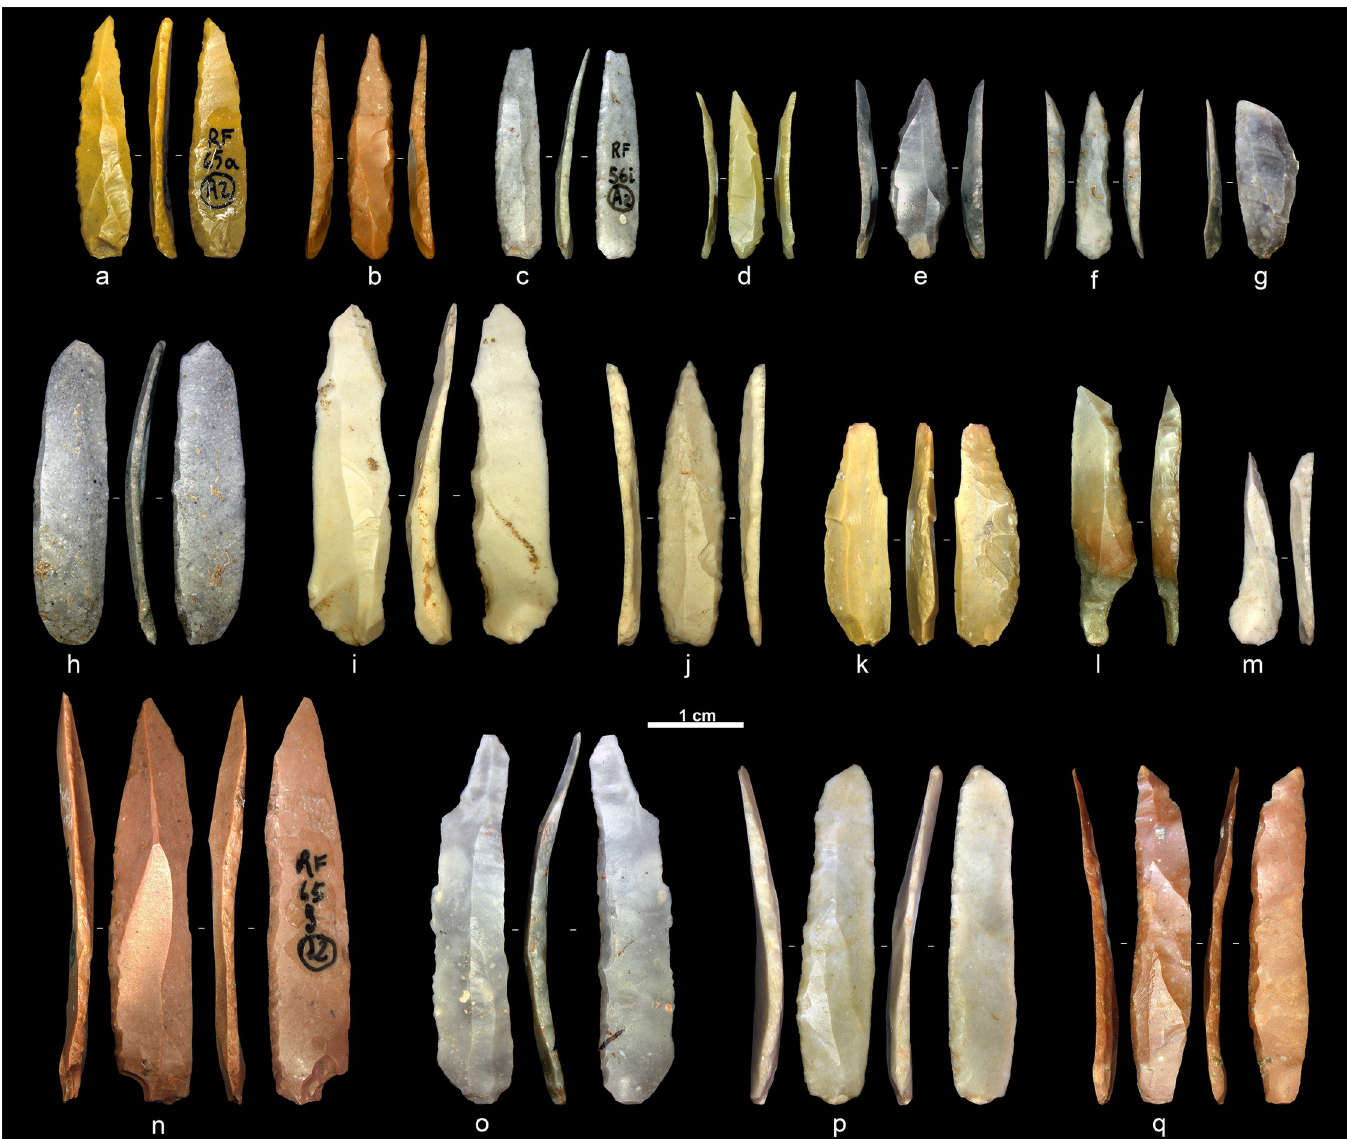
Fig 4. Selection of retouched bladelets. a, c, n, p–q: alternate retouch; b, d, e–f, j: direct bilateral retouch; g, l–m: direct unilateral retouch; h–i, k, o: inverse retouch. Artifacts are oriented with the butt at the bottom of the figure. (Photos: A. Falcucci).